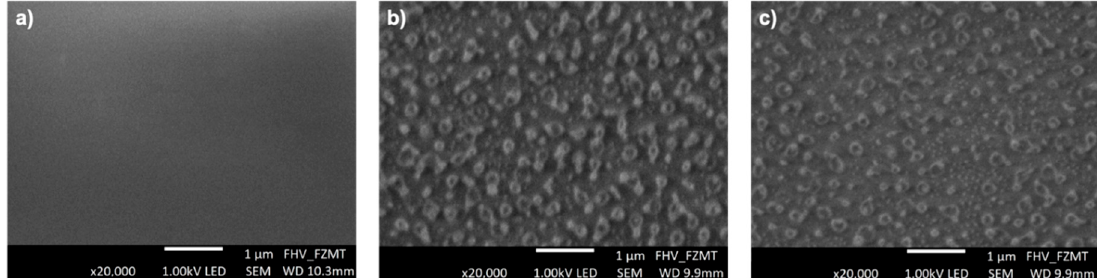
Figure 3. SEM images of ( a ) untreated, ( b ) and ( c ) plasma activated PMMA foils: under 100% O 2 for 5 min, at a power of 1000 W and with a substrate temperature of 20 and 80 °C, respectively.